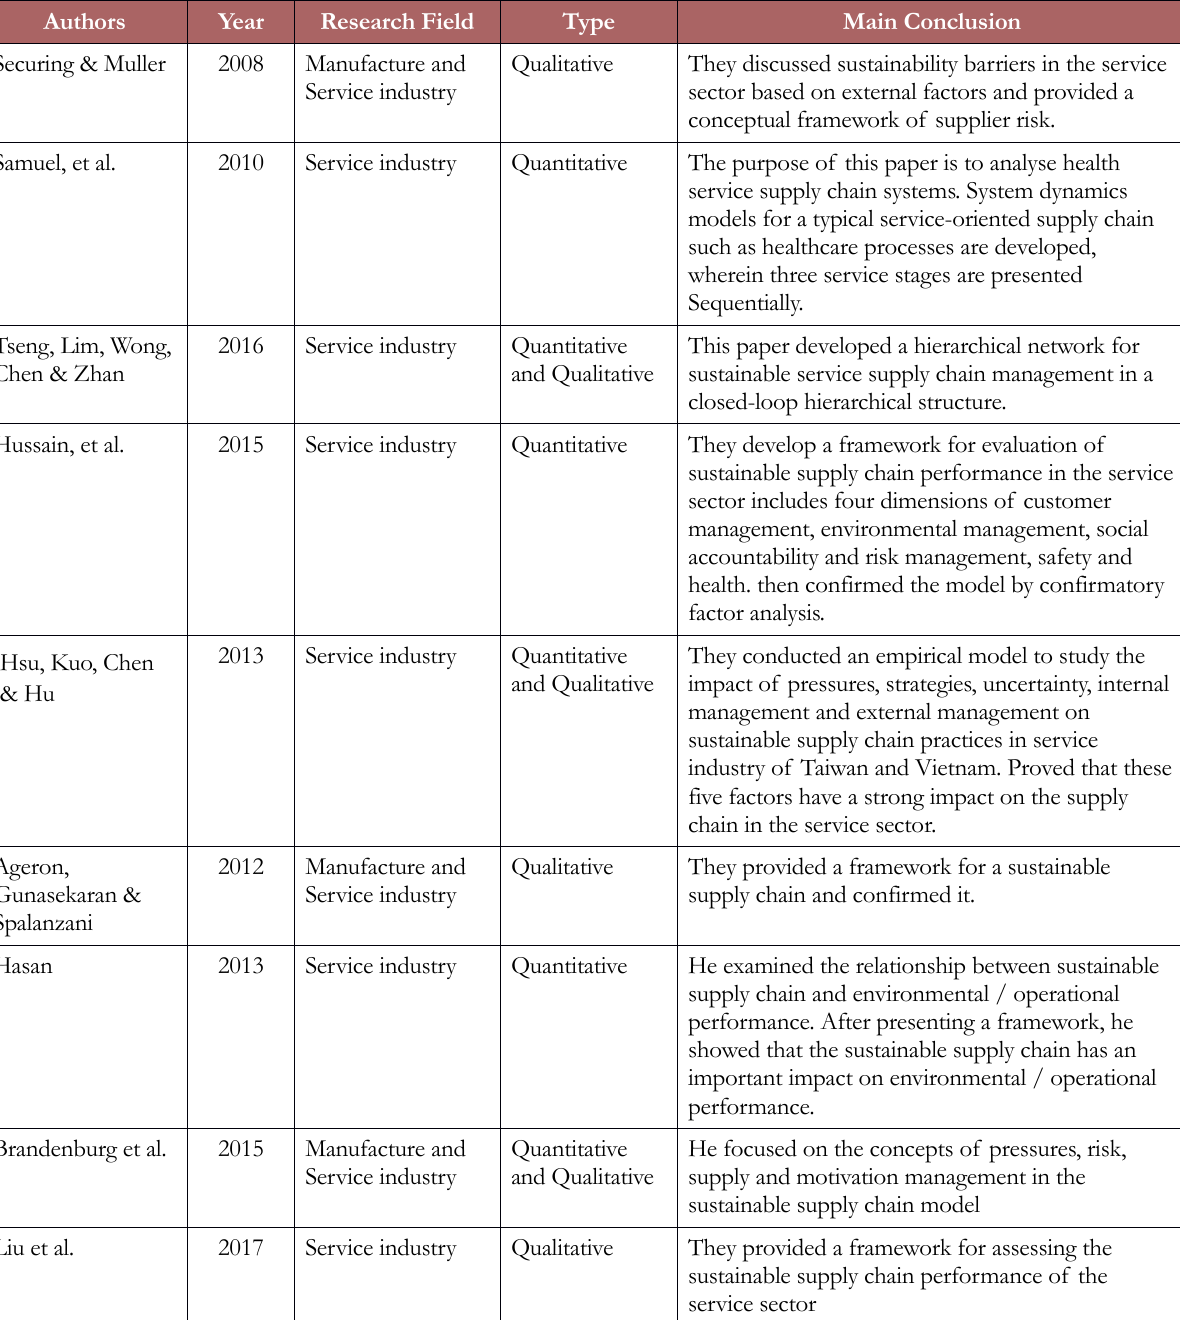
Table 1. Sustainable supply chain management based on